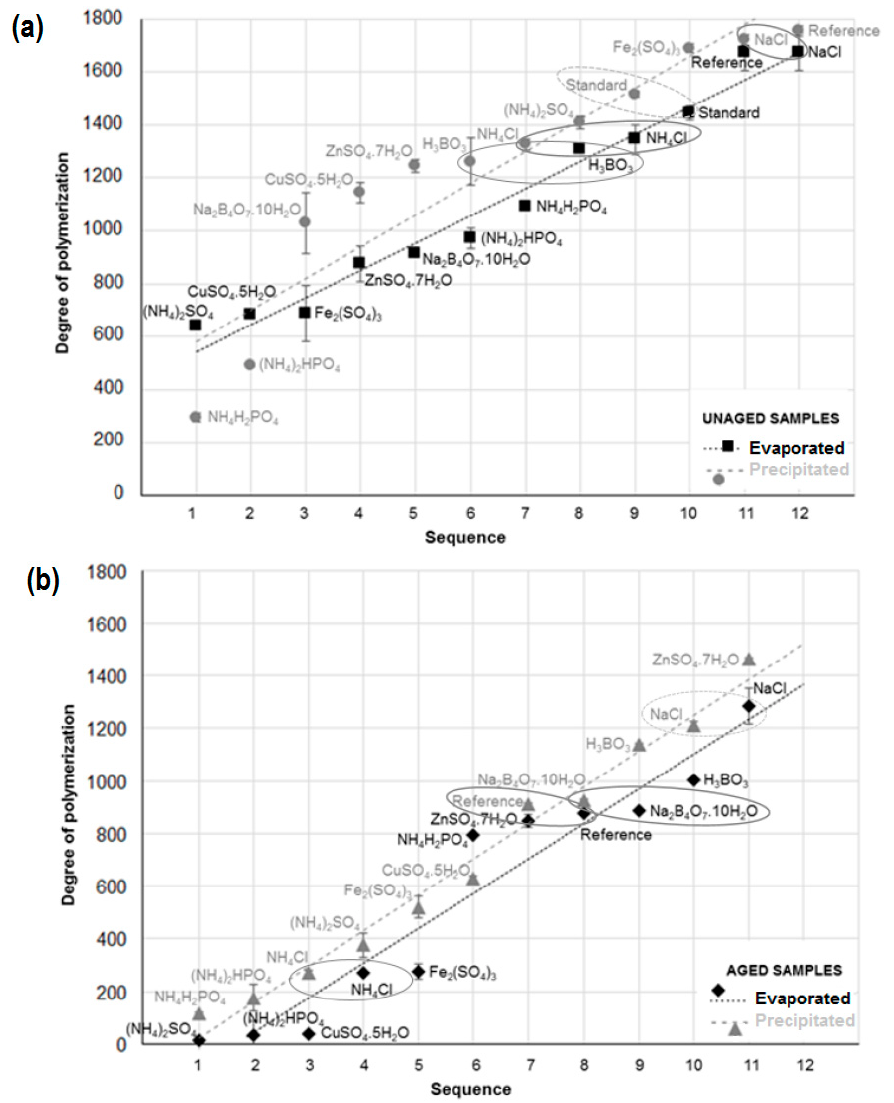
Figure 5. Graphical comparison of average degrees of polymerization for chemically treated cellulose when determination was performed using precipitated and evaporated samples within the group of ( a ) unaged samples and ( b ) samples after accelerated aging.